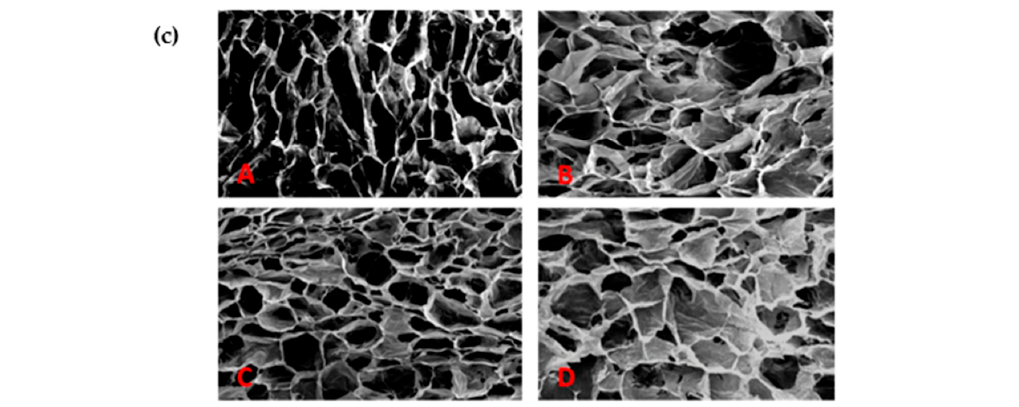
Figure 2. Effects of different concentration of nanocellulose on ( a ) The porosity of bilayer hybrid scaffold. ( b ) The pore size. ( c ) The cross-sectional SEM images of the scaffold at 50X magnification where (A) POC (Control); (B) 1 mL collagen with 1 mg nanocellulose (ColNc 1); (C) 1 mL collagen with 5 mg nanocellulose (ColNc 5); (D) 1 mL collagen with 10 mg nanocellulose (ColNc 10). (*) represents a significant difference ( p < 0.05; n = 3) between control group, POC. The porosity of scaffolds increased while the pore size decreased with higher concentration of nanocellulose.